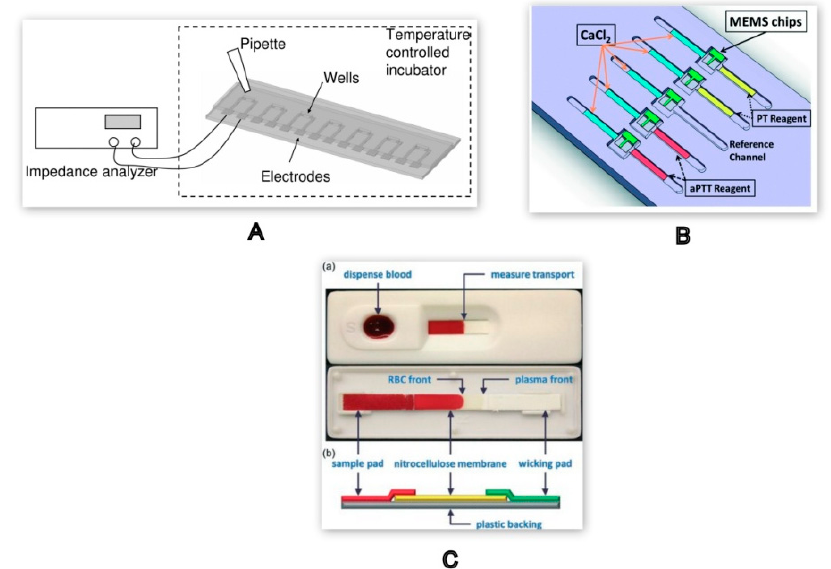
Figure 6. A . High-throughput microfluidic chip with seven parallel wells for measuring blood coagulation time [42]. B . MEMS-based microfluidic device [43]. C . Schematic representation of a paper-based microfluidic chip. Taken with permission from